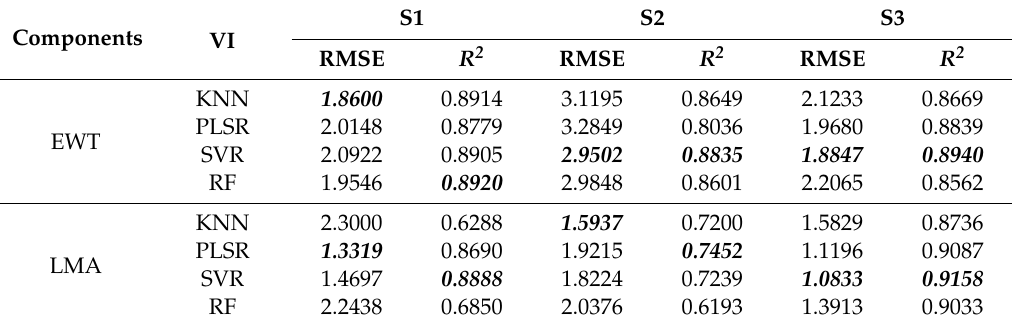
Table 6. Performance of the validation of the ML-VI-based models for the estimation of EWT and LMA. The italic bold number gives the best performances under a given sampling